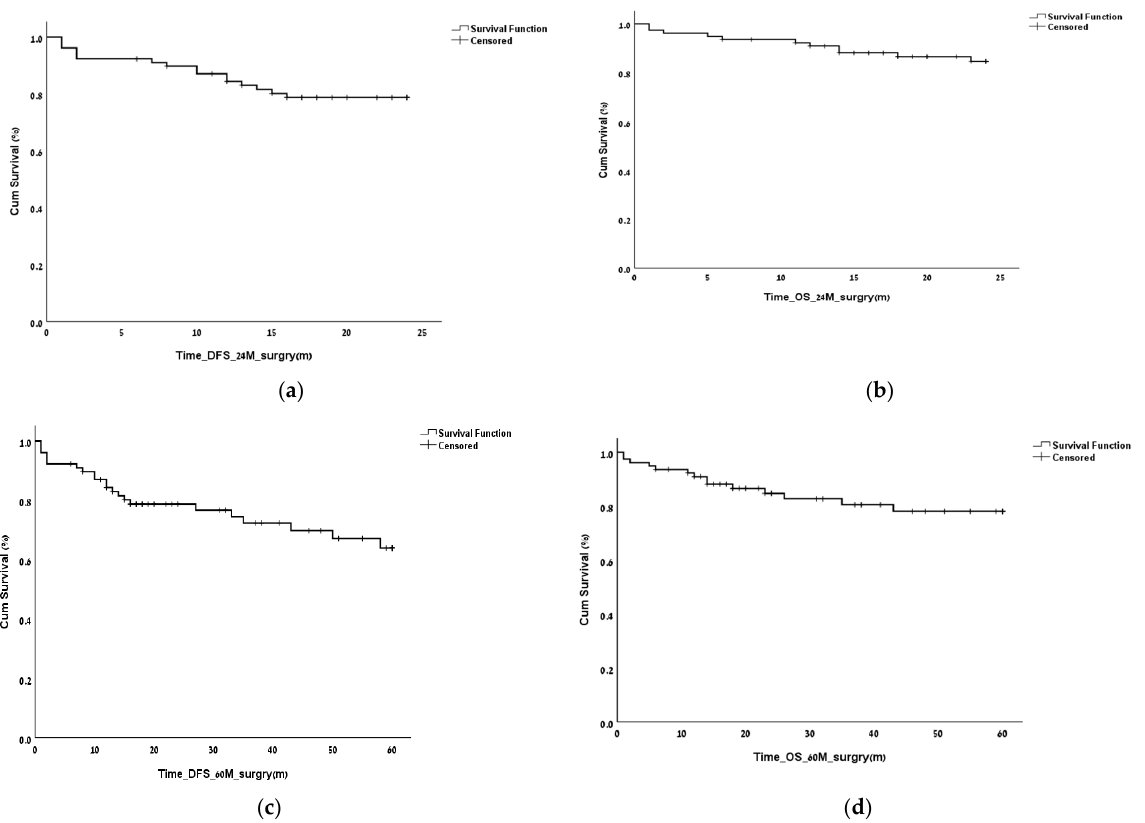
Figure 1. Overall survival (OS) and disease-free survival (DFS) of the entire cohort at 2 and 5 years. OS and DFS at 2 years postoperatively ( a,b ) and after 5 years postoperatively ( c,d ). Tumor grade significantly affected the DFS and the OS at 2 and 5 years, and the effect was preserved after adjustment for the selected variables (vascular invasion, smoking di- abetes, age, sex, metastatic disease at diagnosis, and adjuvant therapy) (Figure 2). No cut- off for positive LNs was found to have a significant effect on either DFS or OS.